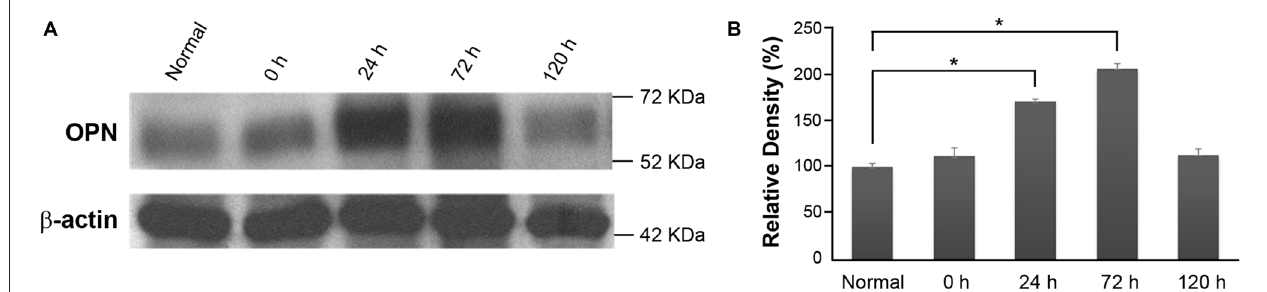
FIGURE 2 | Osteopontin (OPN) expression in blue LED-induced RD retinas. (A) Representative western blot. A representative 66-kDa band was identified with anti-OPN labeling and thus recognized as OPN. (B) Densitometric analysis of the 66 kDa OPN band. Results are expressed as percentages (%) relative to normal control retina values. Data represent the mean ± standard deviation (SD) for four mice in each group. ∗ P < 0.05.